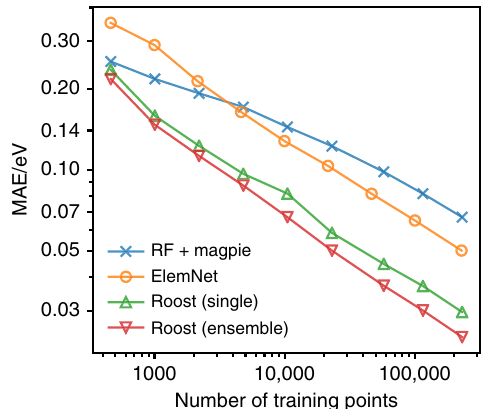
Fig. 2 Sample ef fi ciency learning curve on OQMD. The fi gure shows learning curves for the OQMD data set as the amount of training data is varied for a fi xed out-of-sample test set. Plotted on log-log scales the trends follow inverse power law as expected from statistical learning theory. Results for ElemNet taken from 46 . Table 1 Performance Benchmarks on OQMD. The table shows the mean absolute error (MAE), and root mean squared error (RMSE) for the baseline and proposed models on 10% of the data that was randomly sampled and withheld as a test set. The bracketed numbers show the standard deviation in the last signi fi cant fi